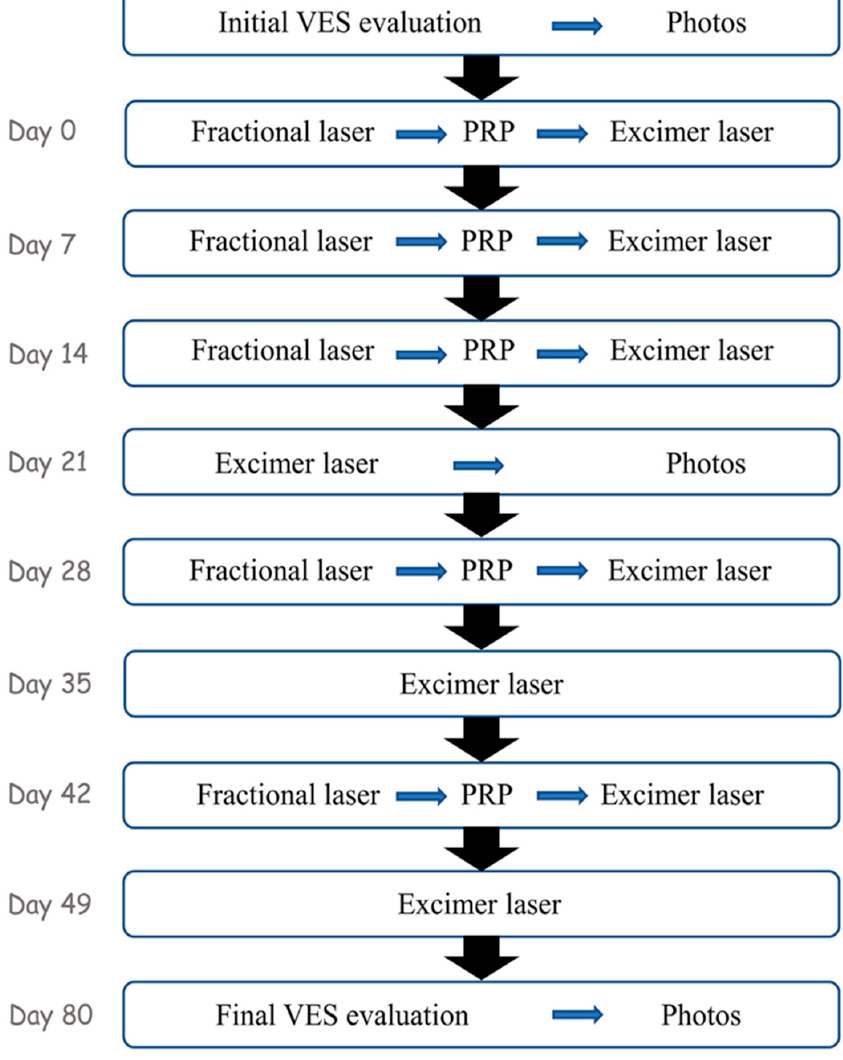
Figure 1. Flowchart of treatments and activities carried out in the 10 sessions.